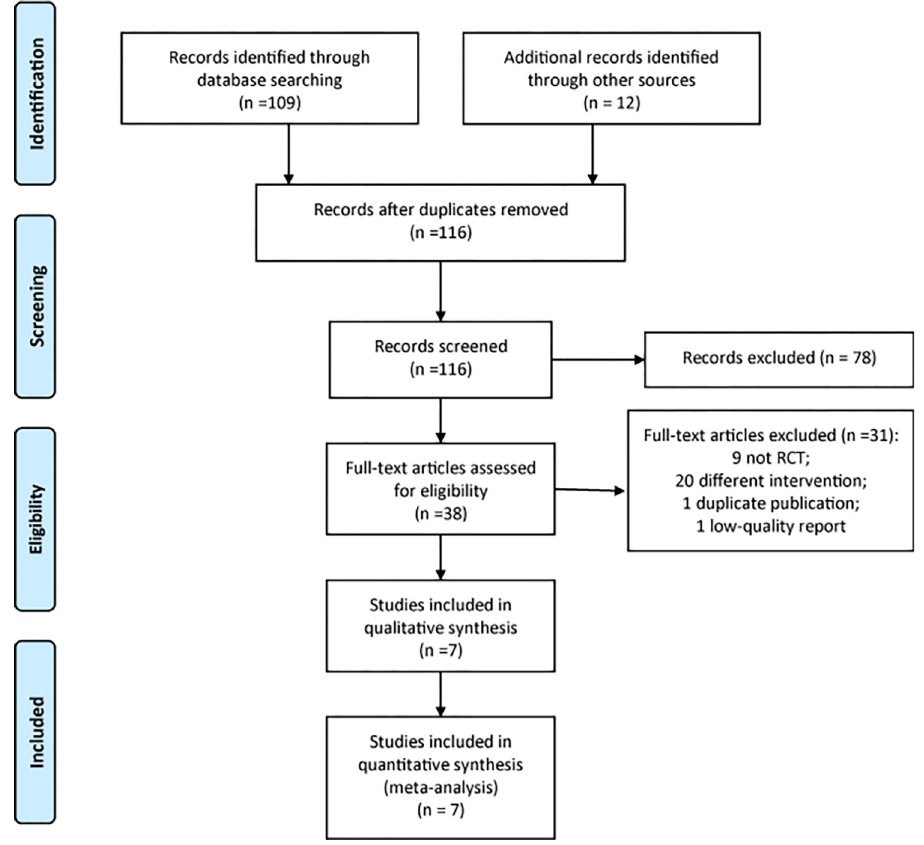
Fig 1. The flow chart of study